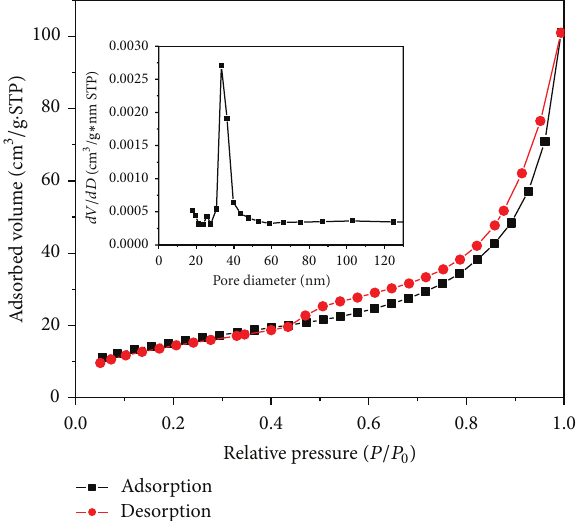
Figure 7: Adsorption/desorption isotherms of S1-10: 10wt% TiO 2 / CdS (10h); inset is the corresponding pore size distribution curves.